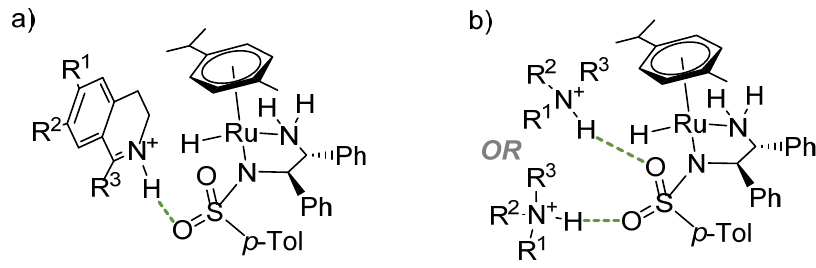
Figure 2. ( a ) Interaction of the sulfonyl group with protonated DHIQ via a hydrogen bond (green dashed line). ( b ) Interaction of the sulfonyl group with protonated amines via hydrogen bonds (green dashed